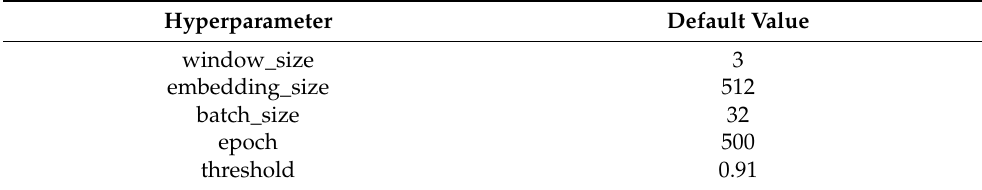
Table 2. Values of hyperparameters.